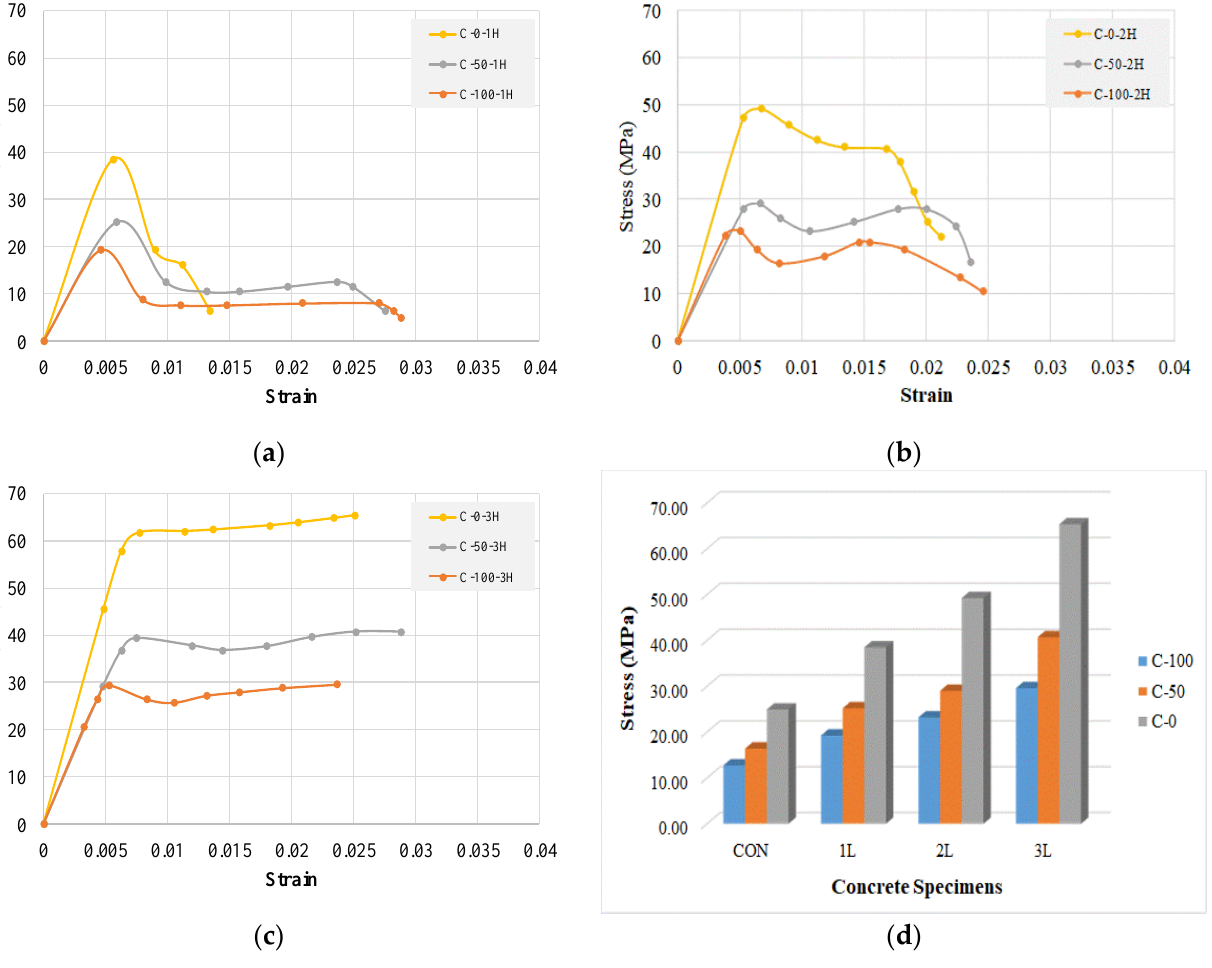
Figure 12. Effect of initial concrete strength on the level of improvement, ( a ) one layer, ( b ) two layers, ( c ) three layers and ( d ) overall comparison.